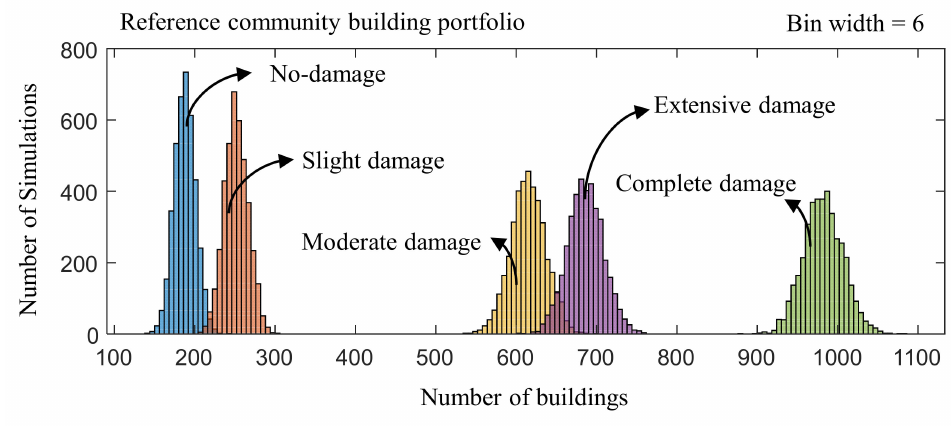
Figure 7. Damage states distributions of community building portfolio under given hazard. Table 1. Statistical moments of damage states of community building portfolio given hazard.